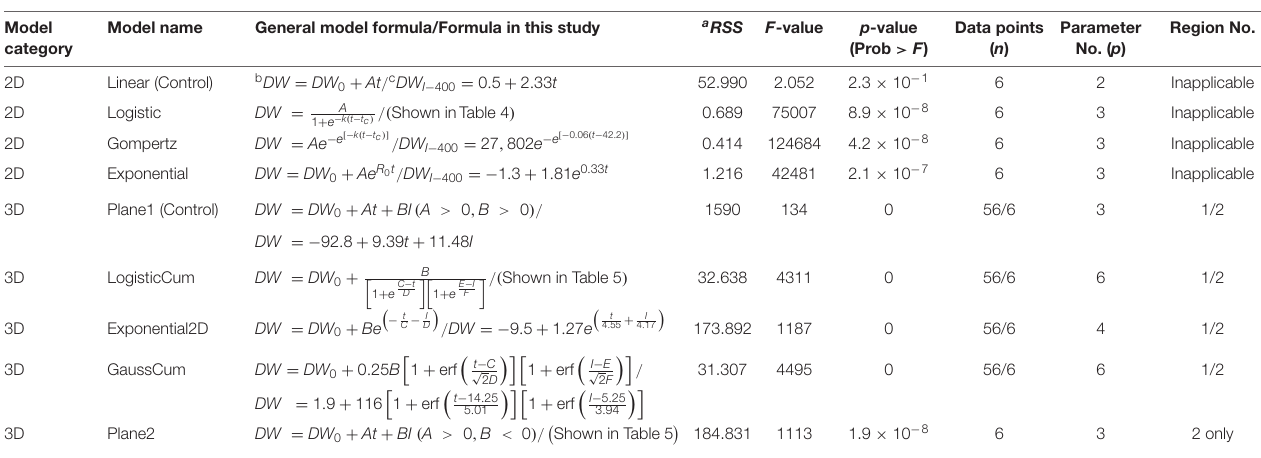
TABLE 2 | The applied 2D and 3D models in this study. Model